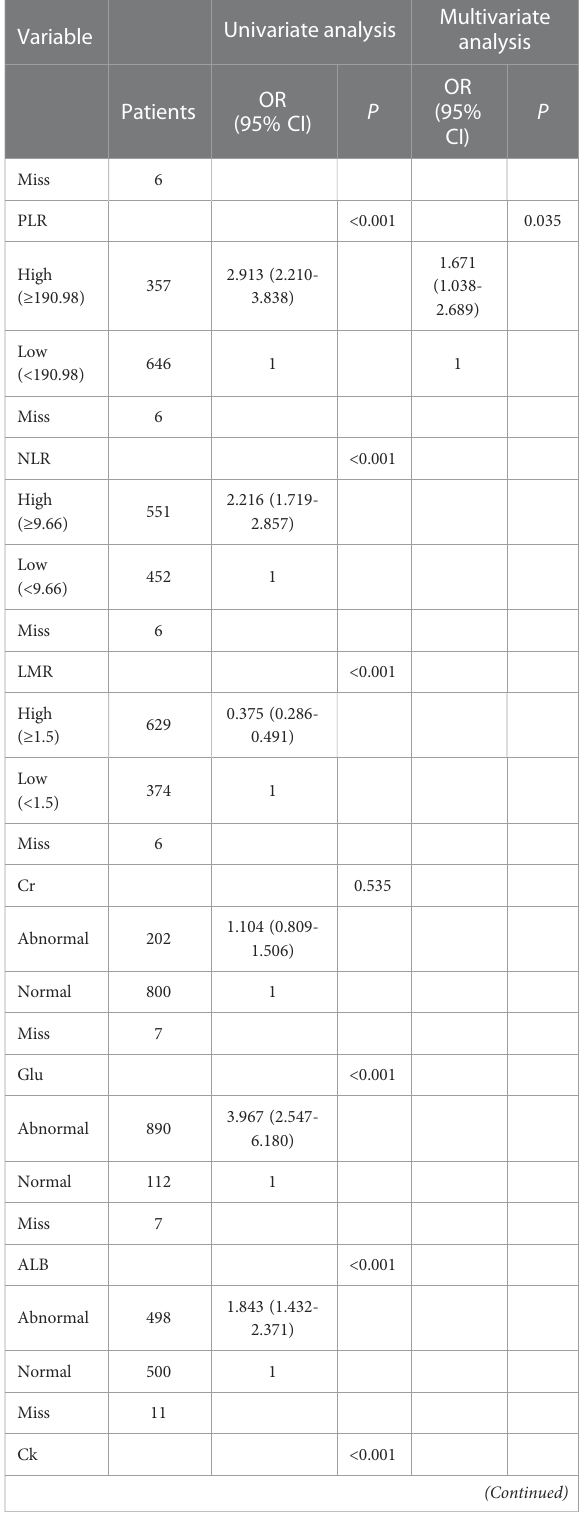
TABLE 3 Univariate and multivariate logistic regression models used to analyze the factors in fl uencing GOS in patients with TBI